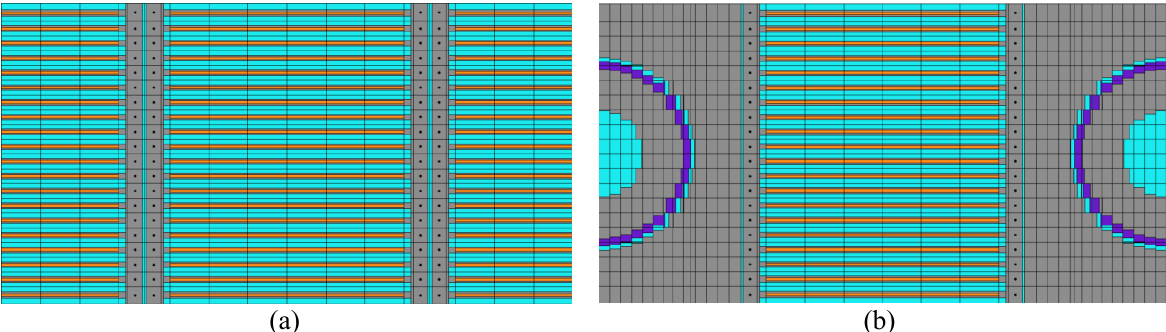
Figure 1. Extended lattice environments used to generate homogenized cross sections for the fuel assemblies.